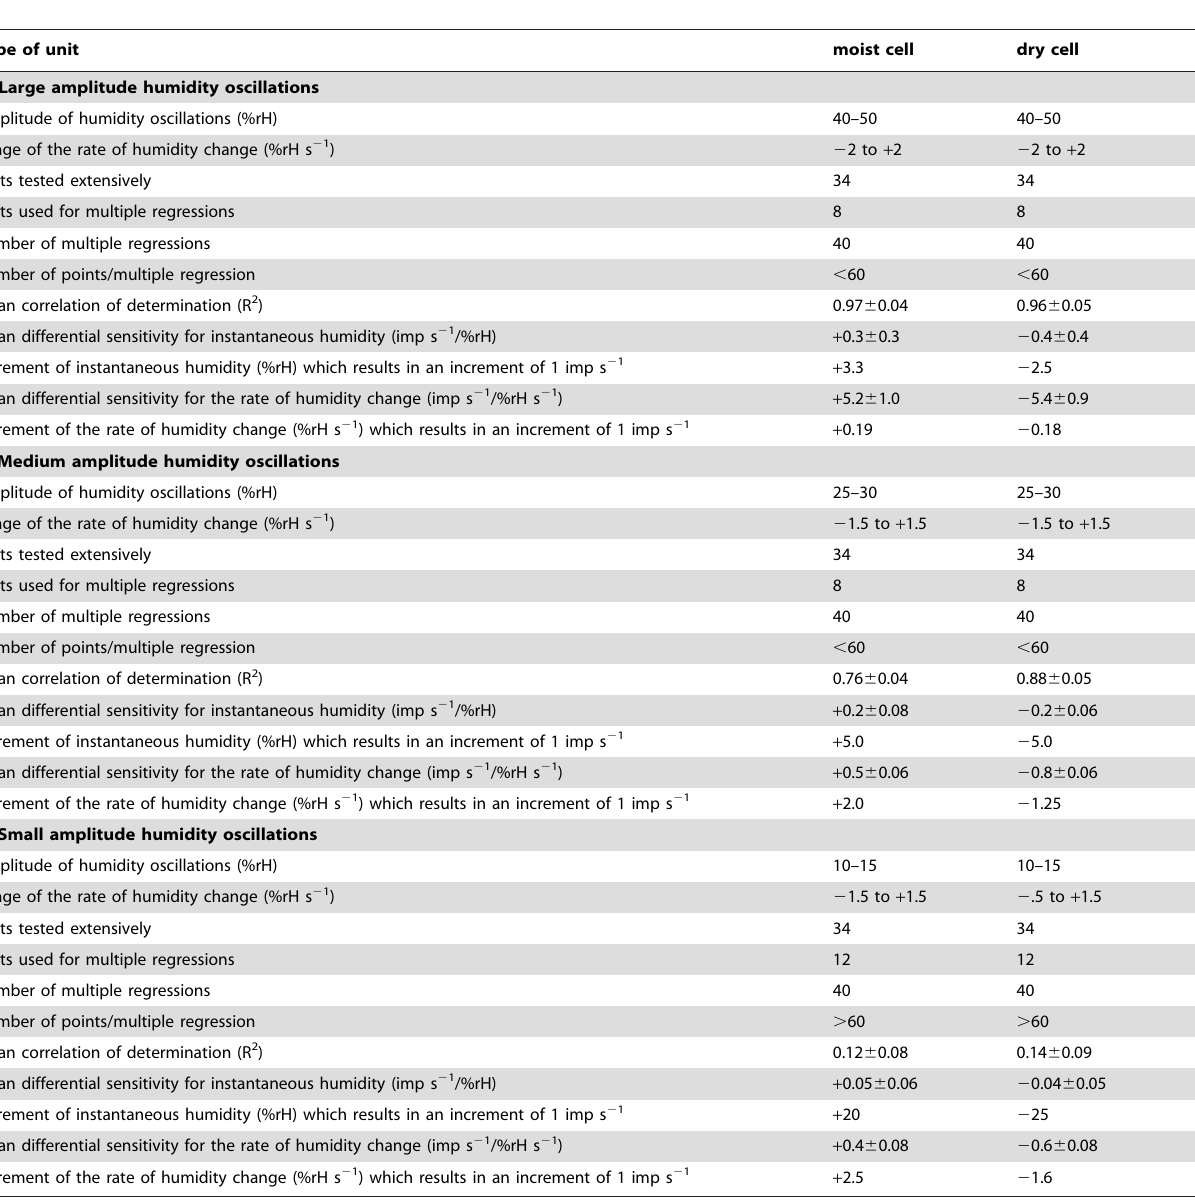
Table 1. Summary of data used to determine differential sensitivities of the moist and dry